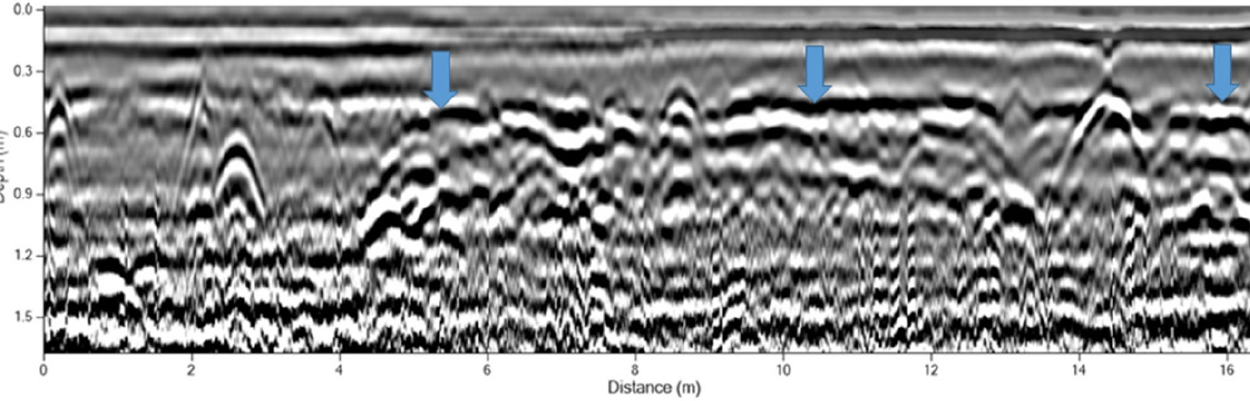
Figure 7. Wall-parallel transect of same feature crossing grid 2 transects seen in Figure 6. The wall feature at ~50 cm depth begins at 4.5 m and continues through end of the transect at 16.5 m.